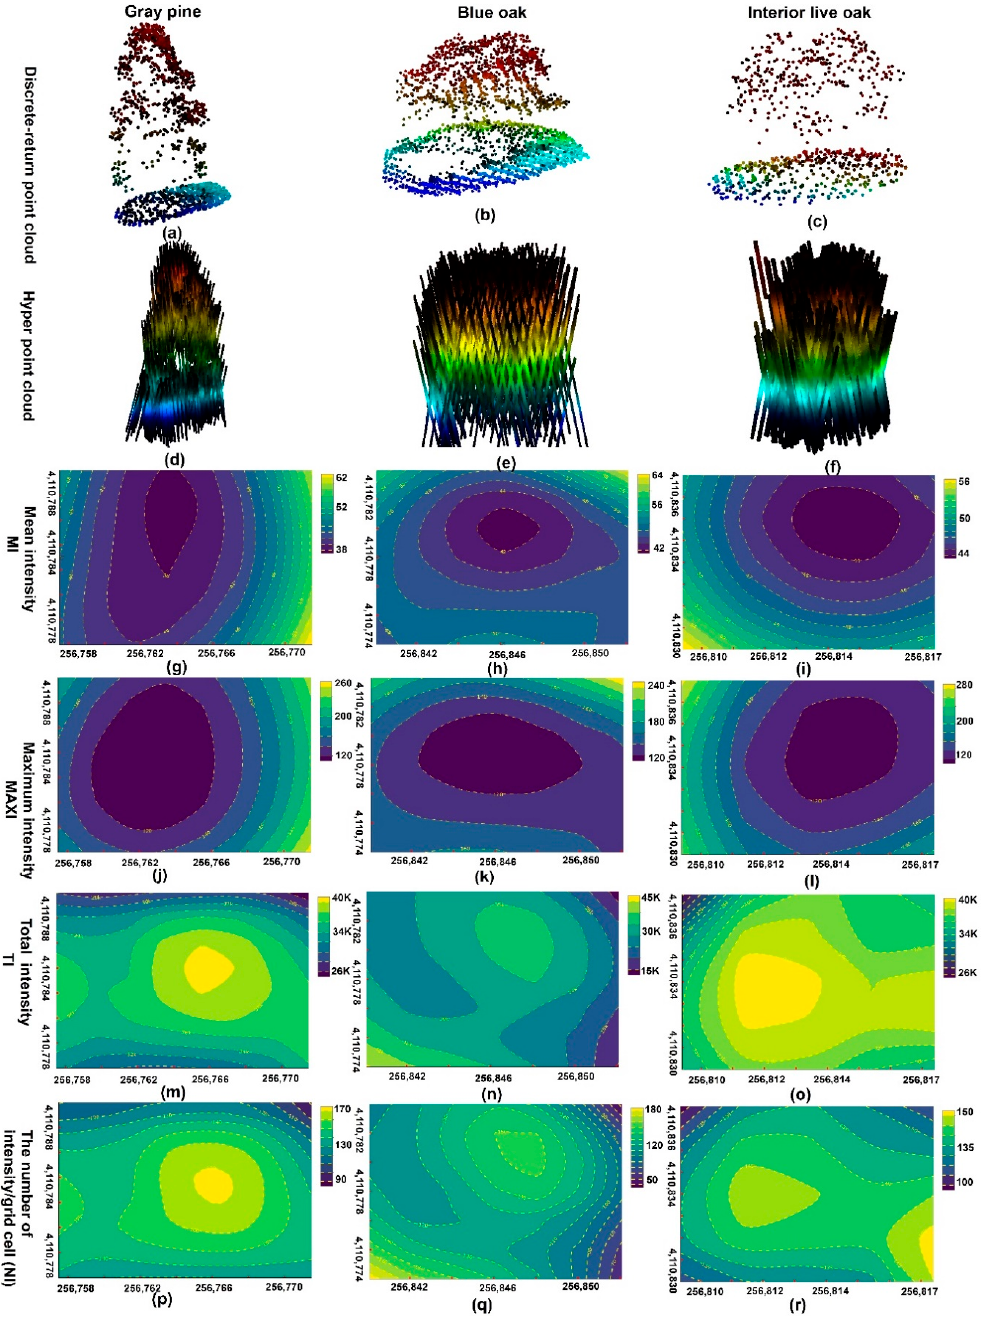
Figure 8. First row: Discrete-return point cloud of three representative individual trees including the ( a ) gray pine, ( b ) blue oak and ( c ) interior live oak. Second row: The HPC of three individual trees ( d ), ( e , f ). Third row: The energy distributions of three representative individual trees ( g – i ) using mean intensity (MI). Fourth row: The energy distribution of three representative individual trees ( j – l ) using maximum intensity (MAXI); Fifth row: The energy distribution of three representative individual trees ( m – o ) using total intensity (TI). Sixth row: The energy distribution of three representative individual trees ( p – r ) using the number of intensity/grid cell (NI) (0.8 m). K: 1000.